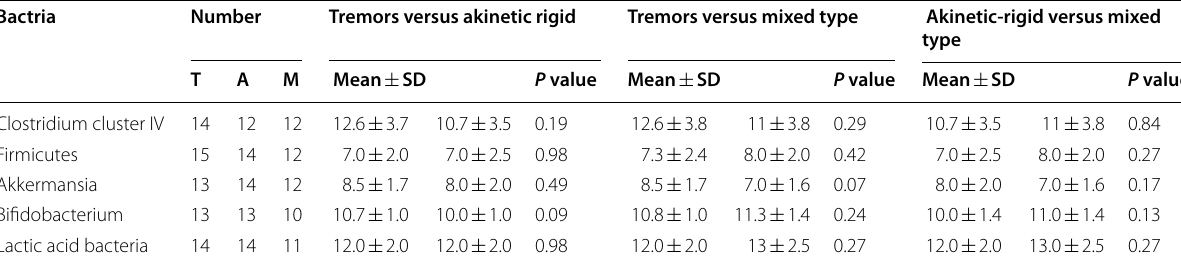
T tremor dominant, A akinetic-rigid, M mixed type